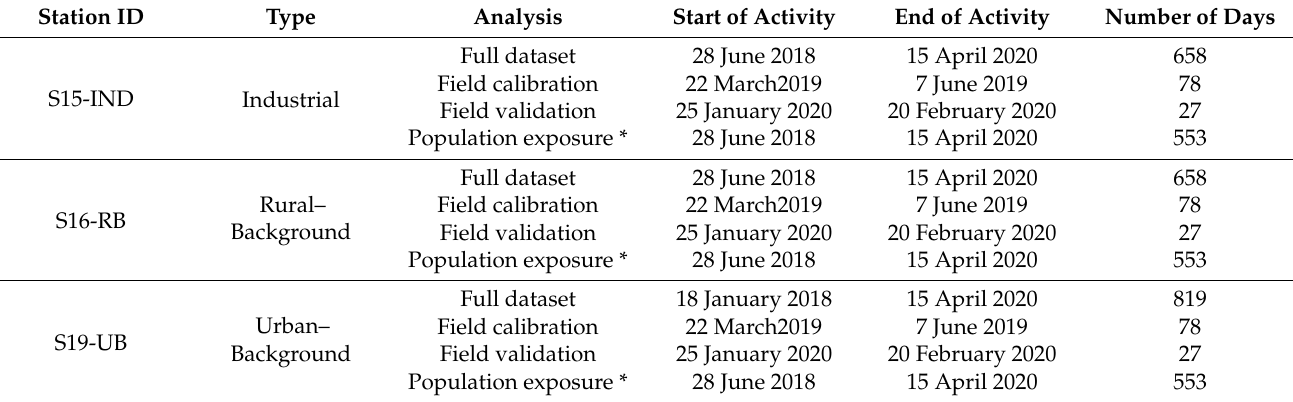
Table 1. Periods of data sources for the different activities were reported in Table 1. * excluding the co-location sub-periods (i.e., field calibration and